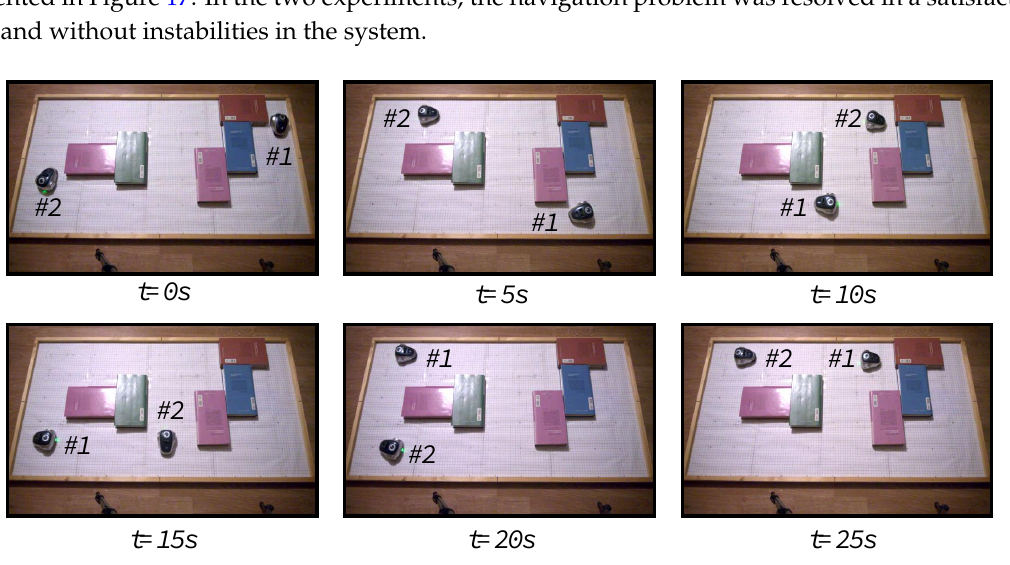
Figure 15. Experiment 1. The obstacle avoidance algorithm using a discrete-time strategy with a centralized controller and two robots. The symbols #1 and #2 represent Robot 1 and Robot 2, respectively.